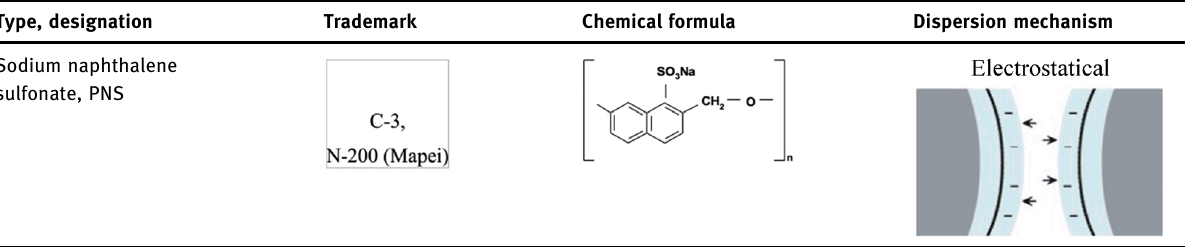
Table 7: Nomenclature and characteristics of plasticizing additives Type,